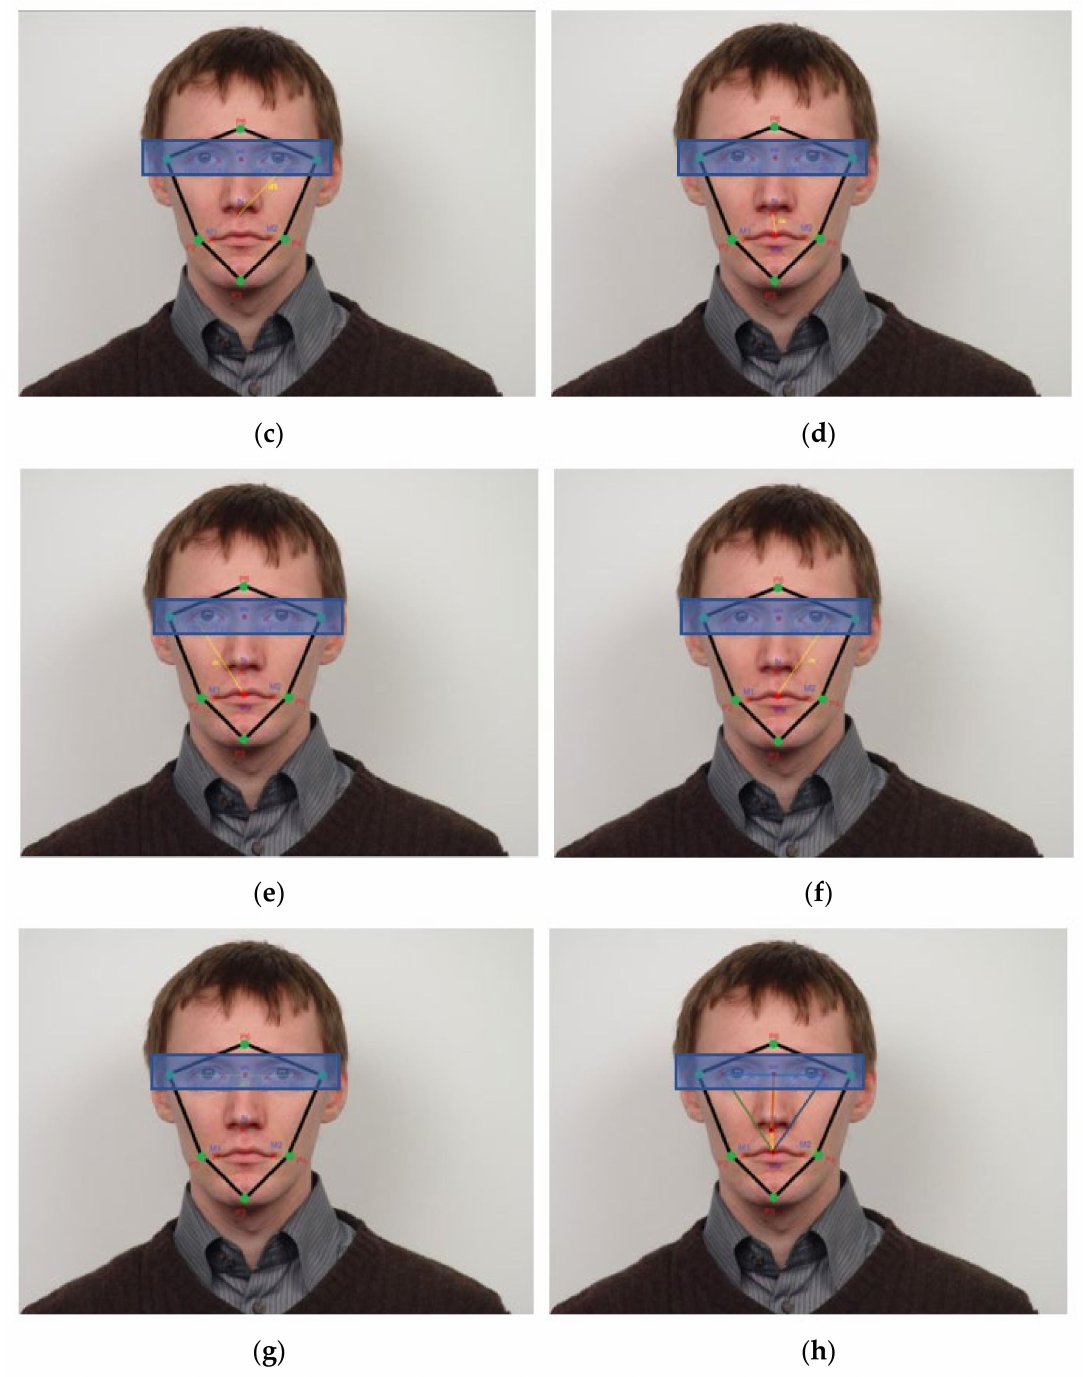
Figure 8. Distance of facial landmarks: ( a ) d1 is the distance from the outer corner of the right eye to the center of the mouth landmarks, ( b ) d2 is the distance from middle point between the center of both eyes to the nose landmark; ( c ) d3 is the distance from the outer corner of the left eye to center of the mouth landmark; ( d ) d4 is the distance from the nose landmark to center of the mouth landmark; ( e ) d5 is the distance from the outer corner of the right eye to the center of the mouth landmark; ( f ) d6 is the distance from outer right eye to the center of the mouth landmark, ( g ) d7 is the distance from outer right eye to outer left eye landmark; ( h ) all distance